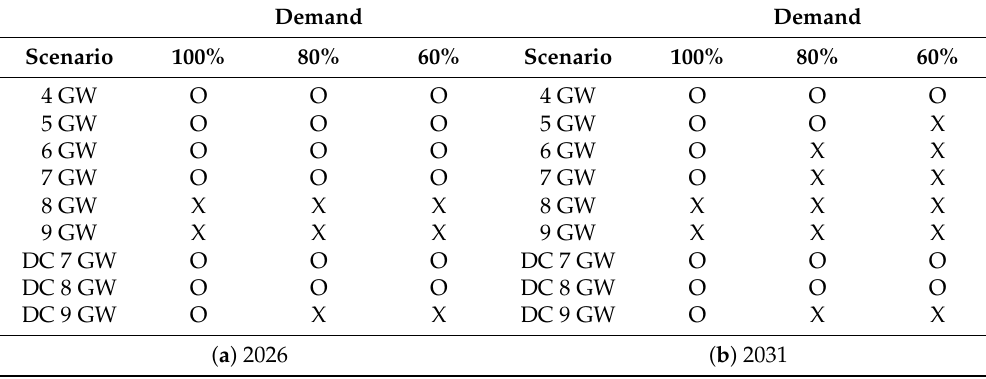
Table 10. The results of the voltage profile analysis for assessing the dynamic performance of renewable energy after a three-phase